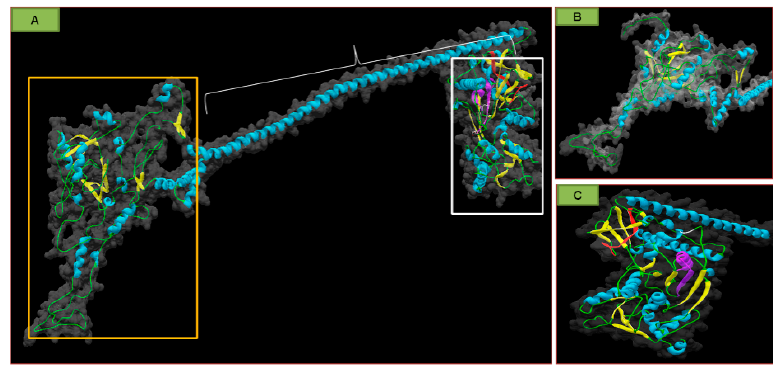
Figure 7. Three-dimensional (3D) model structure of the PDV replicase (P1) protein, considering the surface of both N- and C-terminal domain, and the transmembrane domain (modified Kozieł et al., 2017). ( A ) The colors show the particular elements of the secondary structure, as follows. Green indicates the fragments of straight polypeptide chain, blue— α -helical fragments, yellow— β -card fragments; orange—the frame of methyltransferase domain, white—the frame of helicase domain. The central buckle depicts the helical region between both domains. The protein framework of the 3D structure is marked in gray; ( B ) Magnification of the methyltransferase domain from Figure 6a. Gray indicates protein surface; ( C ) Magnification of the helicase domain (from Figure 6A) rotated 90 degrees vis-à-vis the vertical axis, with the region used for immunolocalization of P1 marked in red. Purple indicates the predicted transmembrane domain. The area of the general framework of the helicase C-terminal domain is represented by the gray color. Kozieł et al. [32], modified.